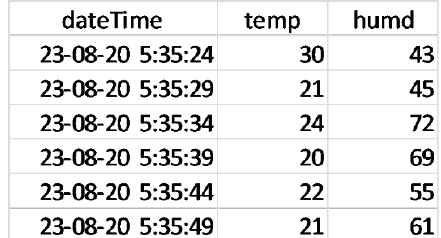
Figure 15. IoT data saved in a .csv file.